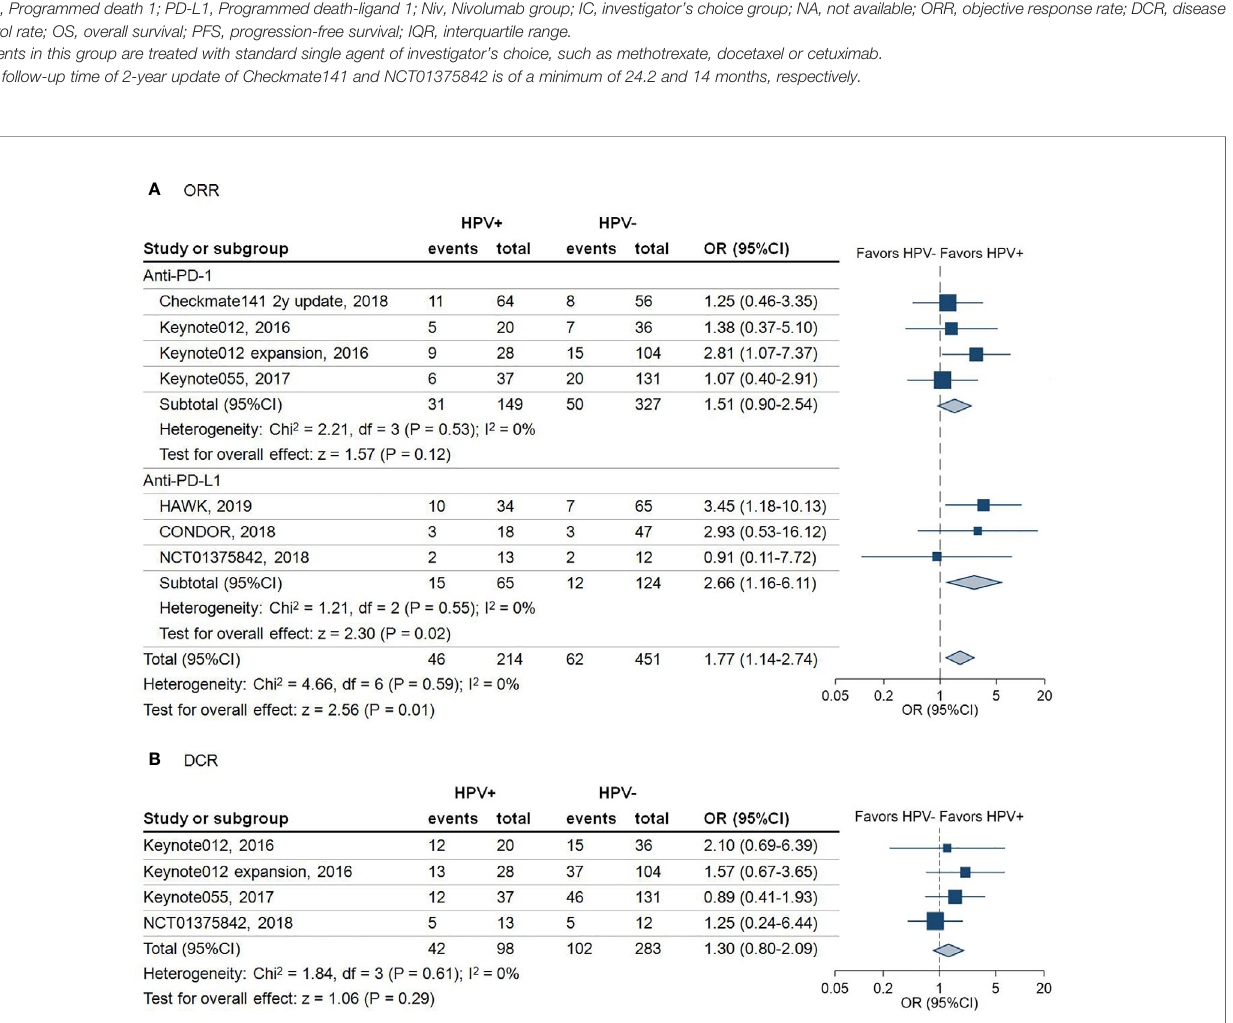
FIGURE 2 | Forest plot for the ef fi cacy of anti-programmed death-1/programmed death-ligand 1 agents in patients with different human papillomavirus status. (A) Objective response rate (ORR) of the included studies strati fi ed by the type of immune checkpoint blockade. Squares indicate adjusted effect size (odds ratio [OR]). Horizontal lines represent 95% con fi dence interval (95%CI). Diamonds represent the pooled ORs; (B) Disease control rate (DCR) of the included studies. Squares indicate adjusted effect size (odds ratio [OR]). Horizontal lines represent 95%CI. Diamonds represent the pooled ORs. Pooled ORs were calculated using the fi xed- effect model. PD-1, Programmed death 1; PD-L1, Programmed death-ligand 1; HPV, human papillomavirus; +, positive; -,